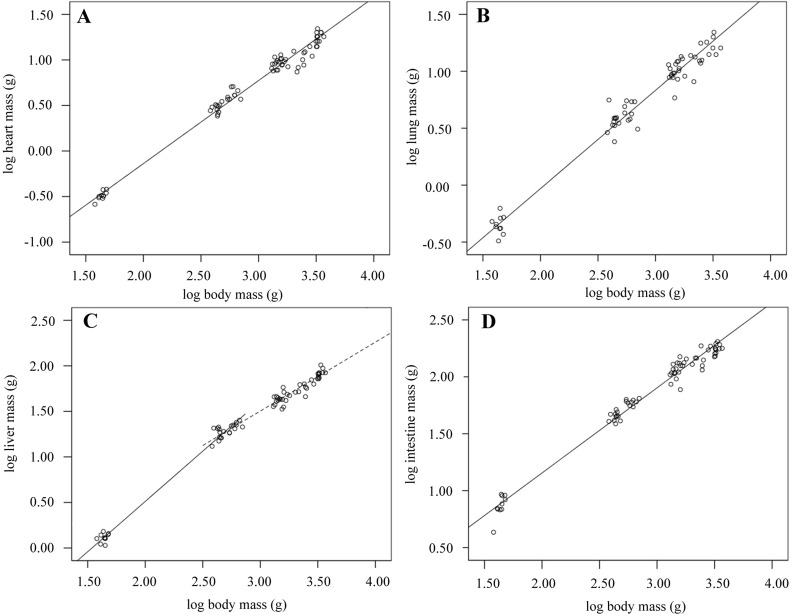
Organ growth during development.Scatterplots showing log transformed organ masses against log body mass over development from hatch to 6-weeks old. The equations describing lines of best fit were: (A) heart: \documentclass[12pt]{minimal}
\usepackage{amsmath}
\usepackage{wasysym}
\usepackage{amsfonts}
\usepackage{amssymb}
\usepackage{amsbsy}
\usepackage{upgreek}
\usepackage{mathrsfs}
\setlength{\oddsidemargin}{-69pt}
\begin{document}
}{}${M}_{\mathrm{b}}^{0.91}$\end{document}Mb0.91–1.96; (n = 69; R2 = 0.98; p < 0.001); (B) lung: \documentclass[12pt]{minimal}
\usepackage{amsmath}
\usepackage{wasysym}
\usepackage{amsfonts}
\usepackage{amssymb}
\usepackage{amsbsy}
\usepackage{upgreek}
\usepackage{mathrsfs}
\setlength{\oddsidemargin}{-69pt}
\begin{document}
}{}${M}_{\mathrm{b}}^{0.86}$\end{document}Mb0.86–1.76 (n = 62; R2 = 0.97; p < 0.001); (C) liver: 0–2 weeks old (solid line): \documentclass[12pt]{minimal}
\usepackage{amsmath}
\usepackage{wasysym}
\usepackage{amsfonts}
\usepackage{amssymb}
\usepackage{amsbsy}
\usepackage{upgreek}
\usepackage{mathrsfs}
\setlength{\oddsidemargin}{-69pt}
\begin{document}
}{}${M}_{\mathrm{b}}^{1.10}$\end{document}Mb1.10–1.70 (n = 30; R2 = 0.99; p < 0.001); 2–6 weeks old (dashed line): \documentclass[12pt]{minimal}
\usepackage{amsmath}
\usepackage{wasysym}
\usepackage{amsfonts}
\usepackage{amssymb}
\usepackage{amsbsy}
\usepackage{upgreek}
\usepackage{mathrsfs}
\setlength{\oddsidemargin}{-69pt}
\begin{document}
}{}${M}_{\mathrm{b}}^{0.76}$\end{document}Mb0.76–0.77 (n = 59; R2 = 0.95; p < 0.001); (D) intestine: \documentclass[12pt]{minimal}
\usepackage{amsmath}
\usepackage{wasysym}
\usepackage{amsfonts}
\usepackage{amssymb}
\usepackage{amsbsy}
\usepackage{upgreek}
\usepackage{mathrsfs}
\setlength{\oddsidemargin}{-69pt}
\begin{document}
}{}${M}_{\mathrm{b}}^{0.75}$\end{document}Mb0.75–0.34 (n = 69; R2 = 0.98; p < 0.001).